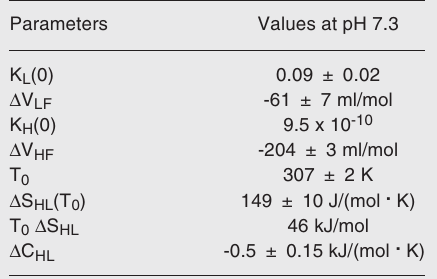
Figure 3. Temperature-depend- ent population the low (L) and high (H) temperature conformer of casein micelles at ambient pressure according to the model of Equation